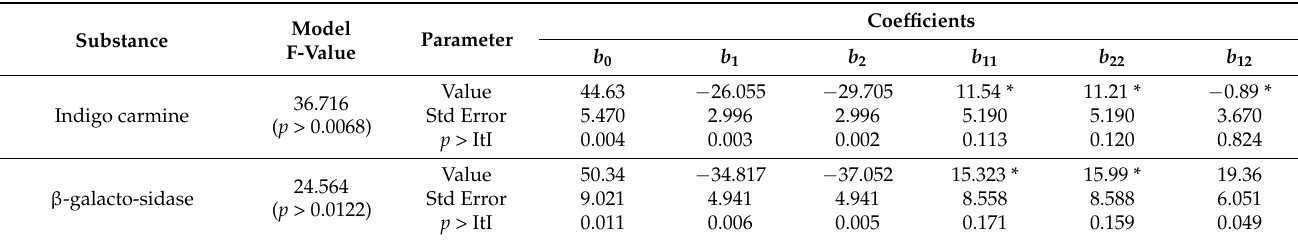
Figure 7. Surface plot of the effects of frequency and temperature on the release of indigo carmine ( A ) or β -galactosidase ( B ). Table 6. Statistical analysis of